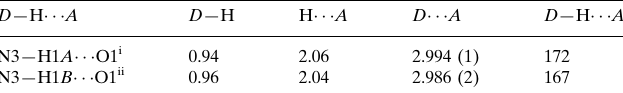
Hydrogen-bond geometry (A˚ , (cid:1)